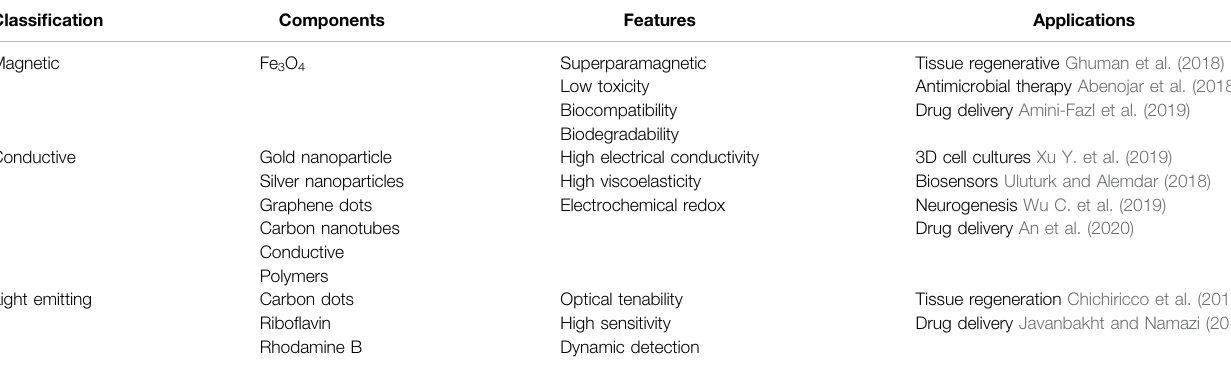
TABLE 1 | Recently developed nanocomposite